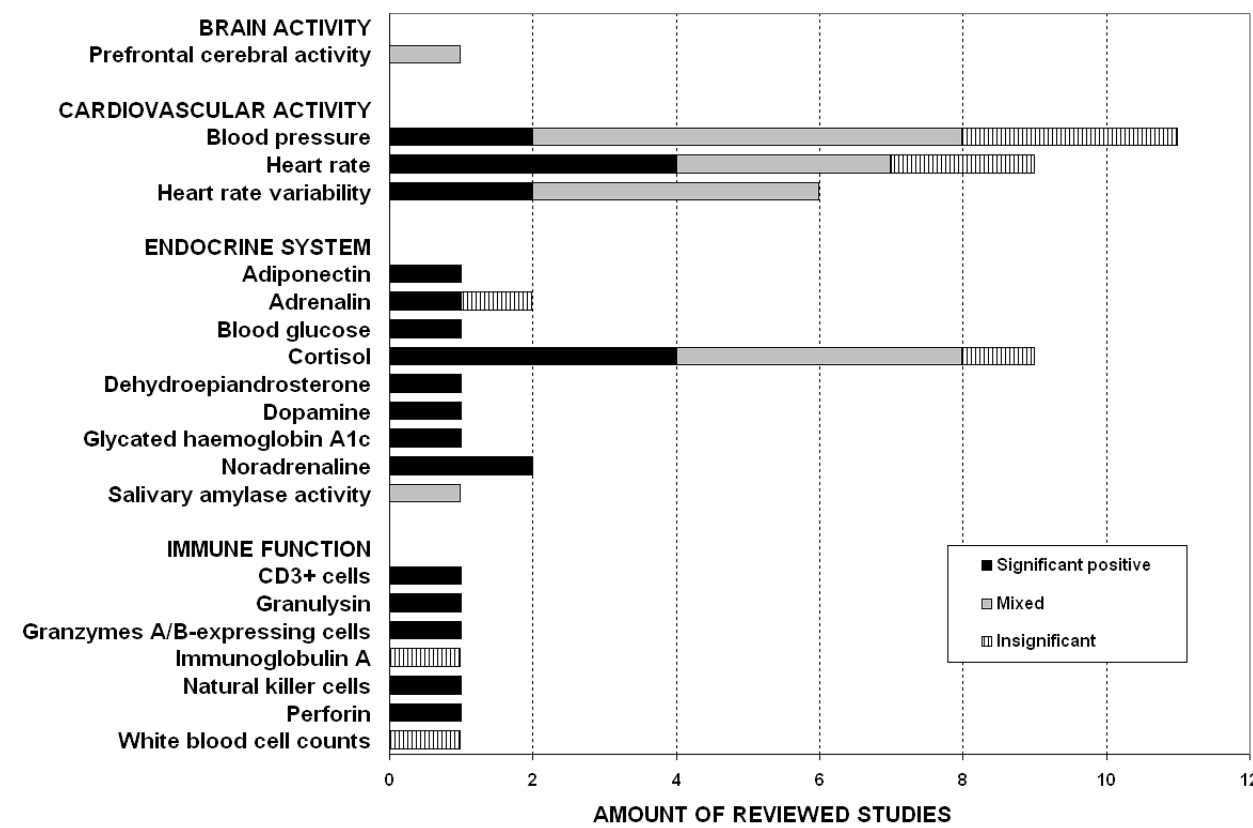
Figure 1. Study outcomes stratified by amount of studies (total n = 17) and physiological parameters. Significant positive (black bars), mixed (grey bars), and insignificant (black and white bars) results are